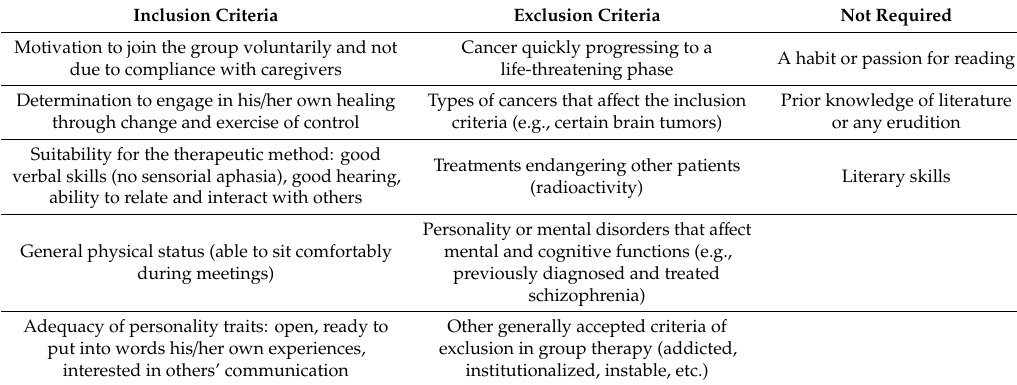
Table 2. Selection criteria.